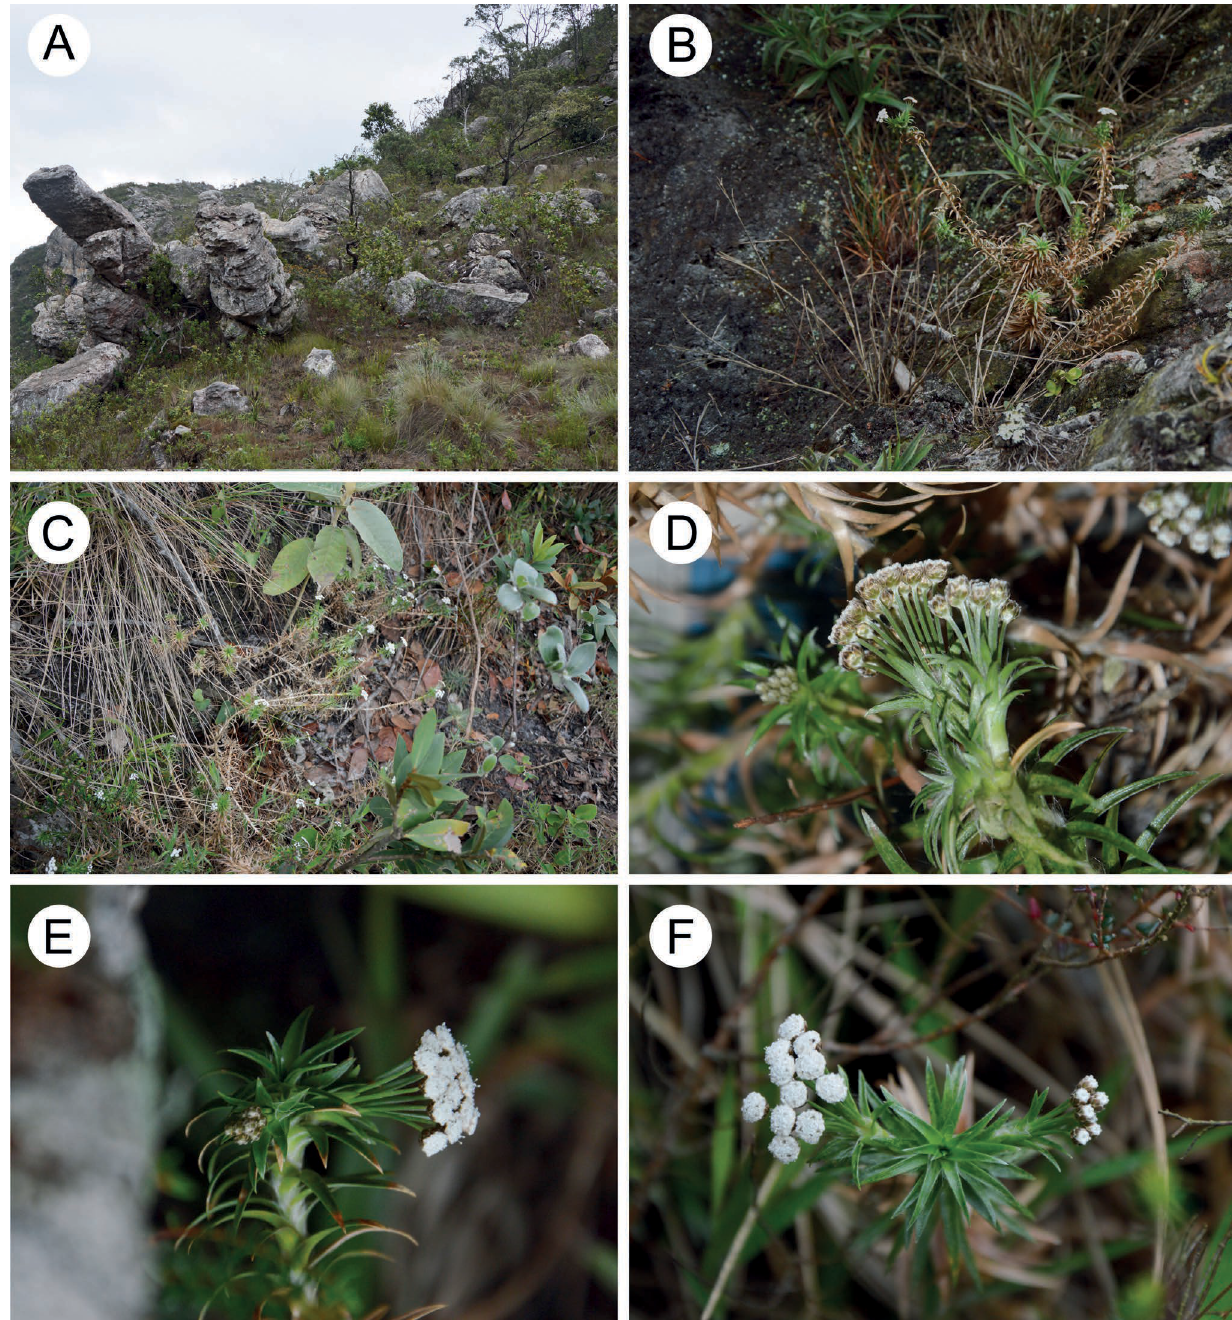
Figure 1 – Habitat, habit, and details of Paepalanthus decumbens (from Picanço et al. 69, R). A, habitat, the campos rupestres in Serra de São José, Minas Gerais; B, general habit, lateral view; C, general habit, apical view; D, branching pattern detail; E, terminal inflorescences, view from the side; F, terminal inflorescences, view from above. Photographs: W.L.